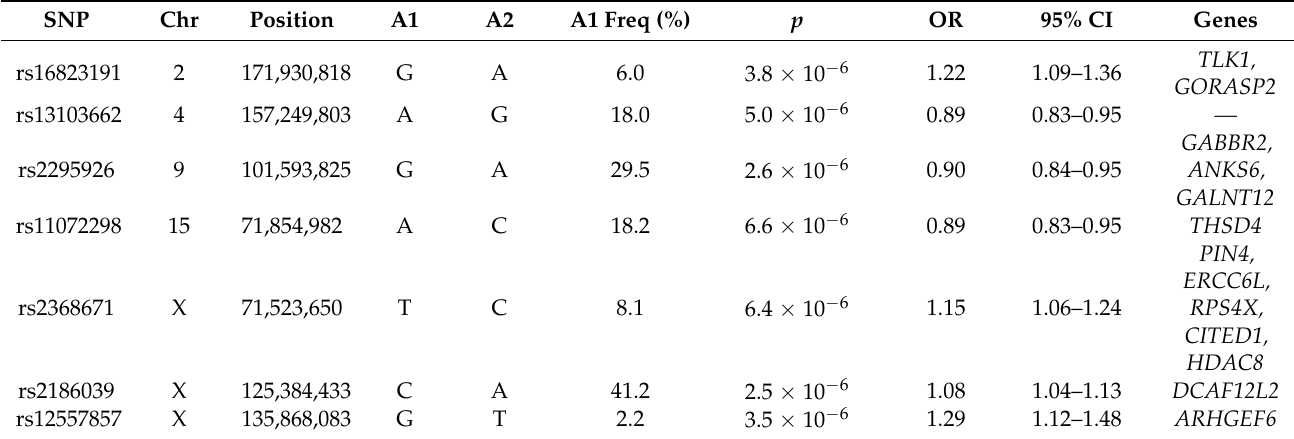
Table 1. Summary of SNPs suggestively associated with